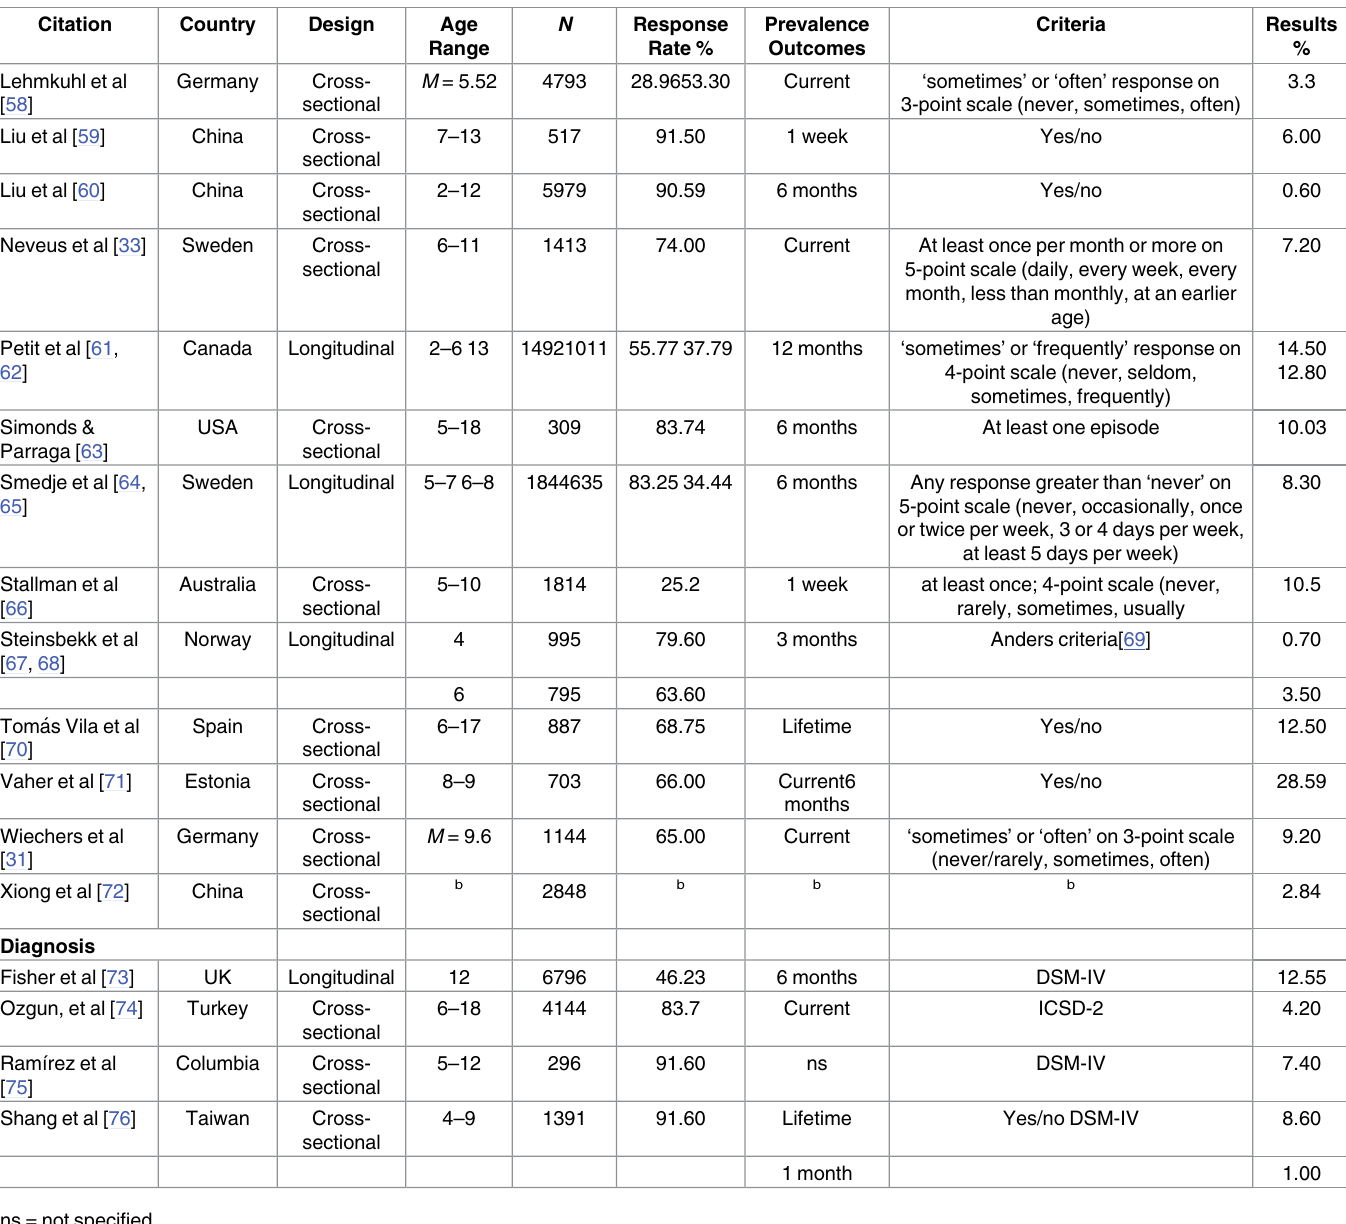
rates (n = 44), they ranged from 4.96% to 99.95%. Twenty-three studies met the minimum cri- teria of 70% response rate to be considered representative of the population [21]. Overall, only 15 papers had no risk of bias for sampling, 17 had risk of bias and 19 had unclear risk. Measurement. Criterion 4—Standardized data collection procedures: More than half of the studies had no risk of bias related to data collection procedures ( n = 29), three had risk of bias, 19 had unclear risk. Criterion 5—Reliable measurement: No studies reported